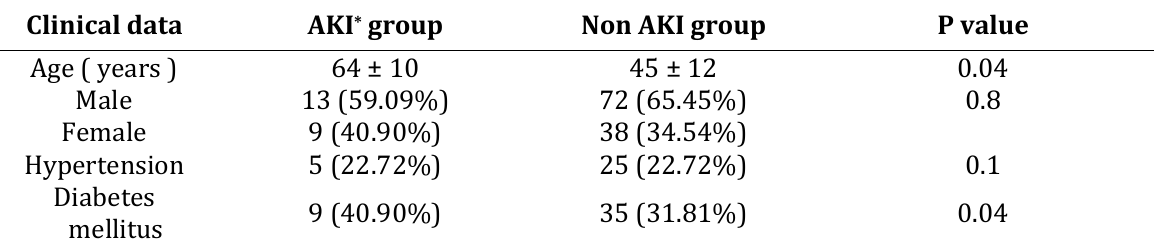
Table-1 Demographic features and comorbidities in study population Clinical data